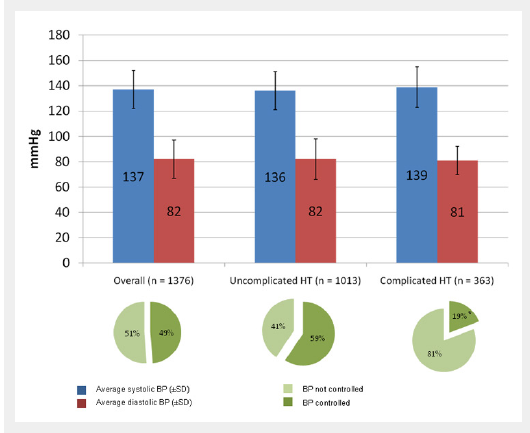
Average systolic and diastolic blood pressure values in the different subgroups of treated hypertensive patients (bar graph). The diagram under the bar graph shows the rate of controlled hypertension according to the individual blood pressure target in the different subgroups. HT: hypertension. BP: blood pressure. SD: standard deviation. * p <0.001, complicated vs uncomplicated